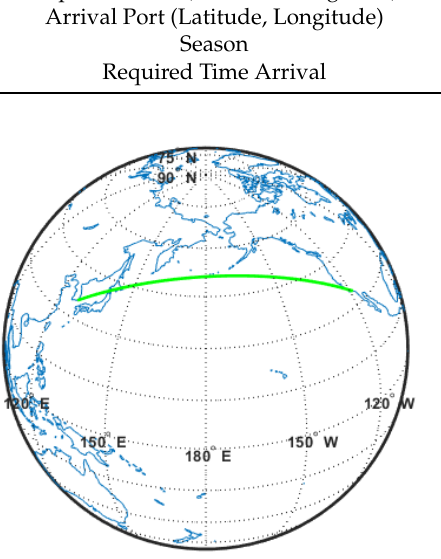
Figure 15. Pacific route case.